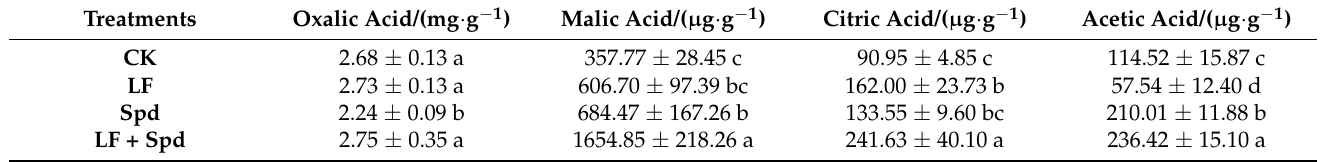
Table 6. Effects of exogenous Spd on organic acid content in tomato roots under low-iron stress.